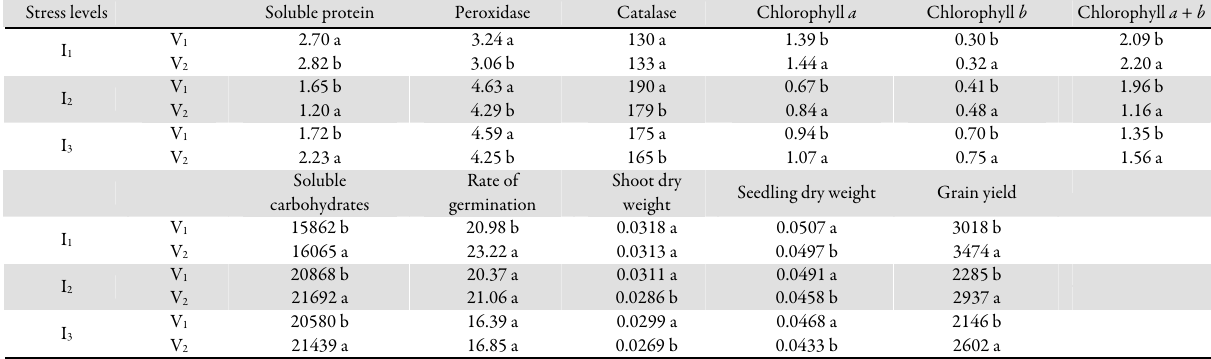
Table 3. Interaction effect of variety and water stress in yield physiological traits and seed vigor of two soybean cultivar Stress levels